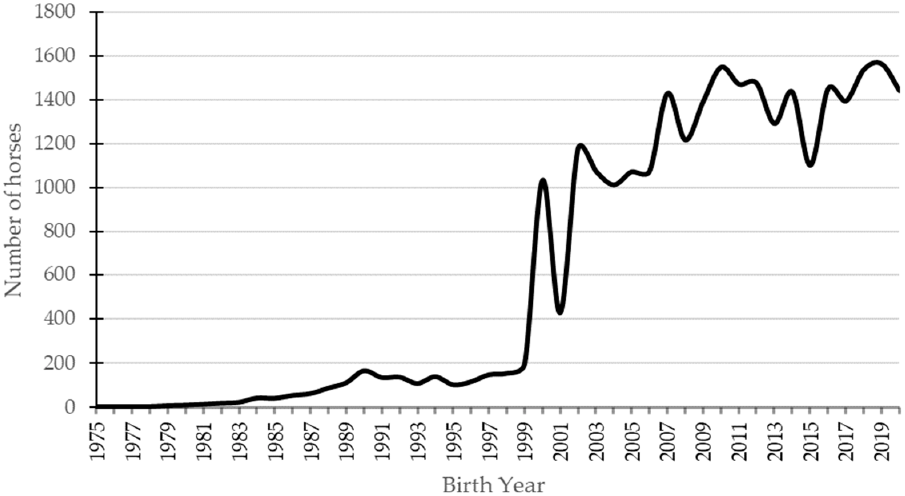
Figure 1. The number of horses registered in the CPH Studbook by birth year. An analysis of all pedigree entries of CPH revealed 25,263 animals for which both parents were known (REF 01, Table 1). The number of founder animals was 1486 and the effective population size of the founders is 162.56. The active living reference population (REF 02) consisted of 5854 active horses.